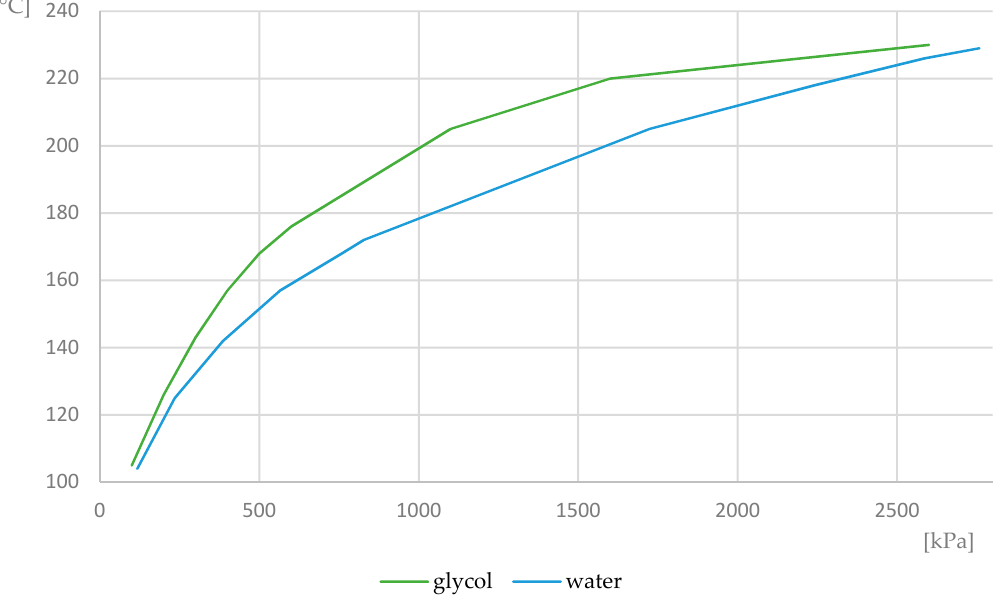
Figure 4. Temperature—pressure diagram water and glycol.